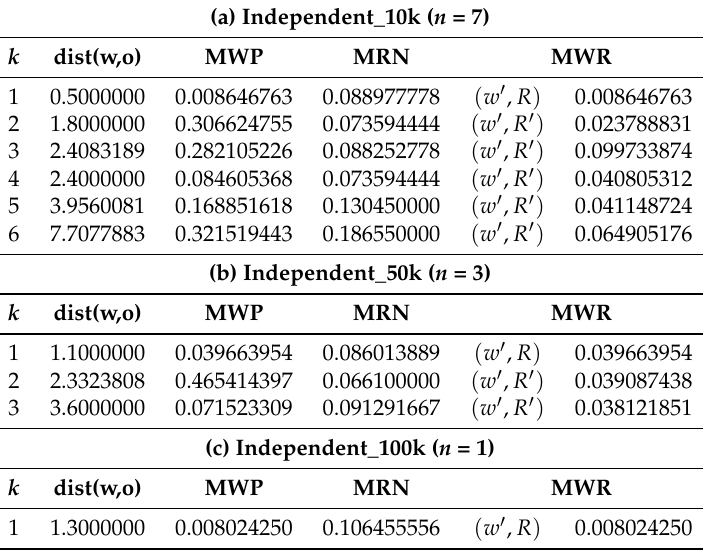
Table 4. Cost for independent data( w ∈ R